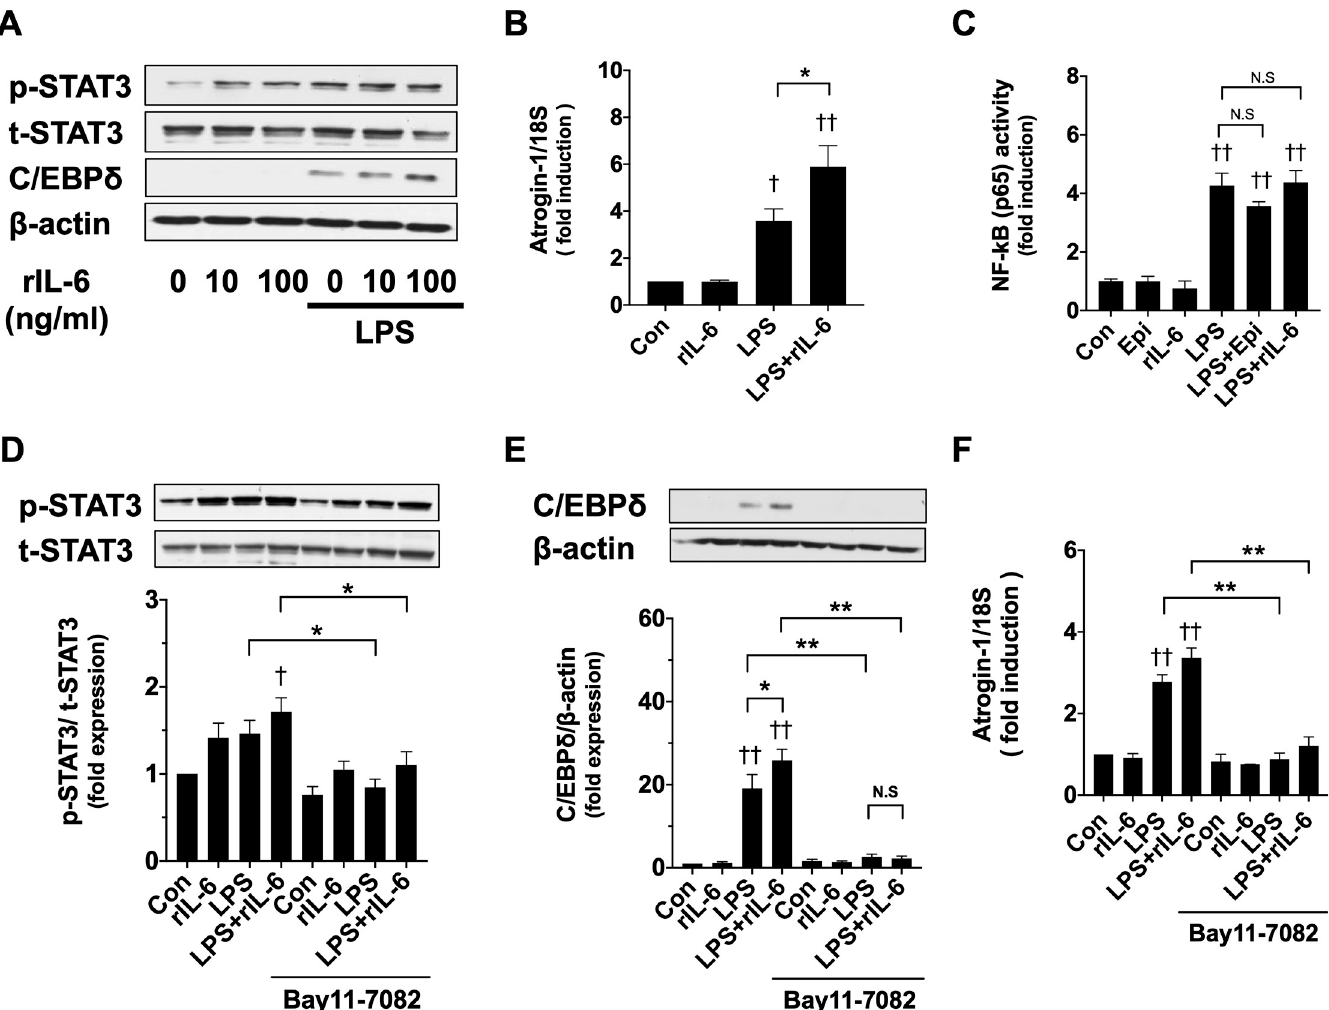
Fig 6. NF- κ B activation is involved in myotube wasting induced by LPS and recombinant IL (rIL)-6. (A) C2C12 myotubes were exposed to rIL-6 (10 and 100 ng/ml) and/or LPS (50 ng/ml) for 3 h. Whole-cell lysates were analyzed for p-STAT3, t-STAT3, C/EBP δ , and β -actin protein expressions by immunoblotting analysis. Representative immunoblots are shown. (B) C2C12 myotubes were exposed to rIL-6 (100 ng/ml) and/or LPS (50 ng/ml) for 3 h, and the Atrogin-1 mRNA levels were analyzed by qRT-PCR. Data are normalized to the 18S ribosomal RNA (rRNA) expression levels, and fold induction relative to the value of the control condition is presented (n = 4). (C) C2C12 myotubes were treated by Epi (1 μ M) and/or LPS (50 ng/ml) for 3 h, and NF- κ B (p65) binding activity was analyzed by a TranAM ELISA kit. Fold induction was calculated relative to the value of the untreated control cells (n = 5). (D, E) C2C12 myotubes, pretreated with the NF- κ B inhibitor Bay 11–7082 (10 μ M) for 30 min were exposed to rIL-6 (100 ng/ml) and/or LPS (50 ng/ml) for 3 h. Representative immunoblots for p-STAT3 (D) and C/EBP δ (E) protein are shown, and the expressions of p-STAT3 (D) and C/EBP δ protein (E) were quantified by densitometric analysis and normalized to the expression levels of t-STAT3 and β -actin, respectively. Fold induction relative to the value of the control condition is presented as mean ± SEM (n = 6). (F) Atrogin-1 mRNA was analyzed by qRT-PCR, and its expression level normalized to the 18S rRNA expression level is presented as mean ± SEM (n = 4) of fold induction relative to the value of the control condition. (†P < 0.05 and ††P < 0.005 compared with control, � P < 0.05 and �� P < 0.005 for comparisons between the indicated